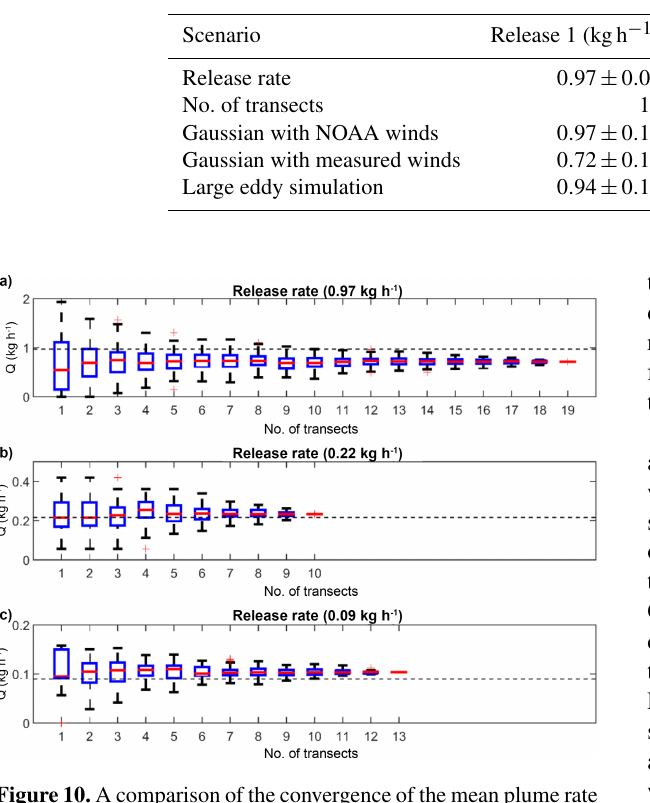
Table 4. Summary of mean emissions from three scenarios for the controlled release ( ± 1 standard deviation of the mean).